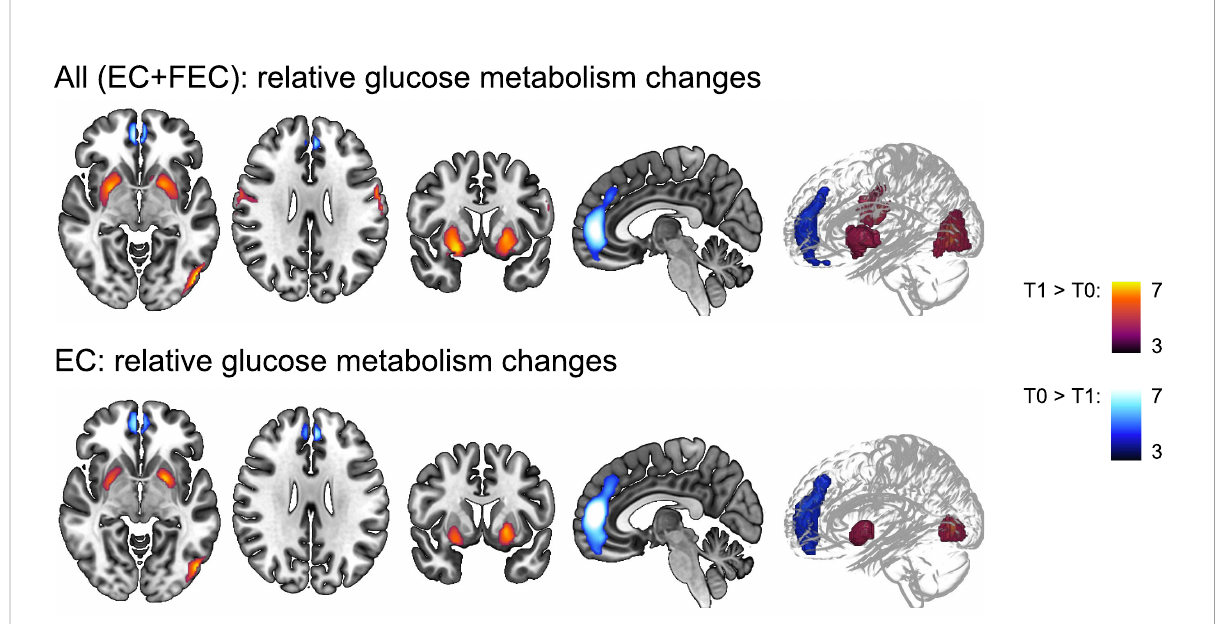
FIGURE 3 Whole-brain voxel-based analysis of relative glucose metabolism before (T0) and after (T1) neo-adjuvant chemotherapy. General linear modelling showed relative decreased (blue colored T-scale, paracingulate gyrus) and increased (red colored T-scale) frontal (central gyrus) glucose metabolism, as well as increased subcortical (putamen and occipital (lateral cortex) metabolism for EC and FEC treated patients combined. Except for the pericentral gyri decrease, the same regions showed changes in relative metabolism for EC patients separately, but not FEC patients. Models were corrected for age and type of scanner ( n =282) scans. Statistical signi fi cance was inferred with a height threshold of p